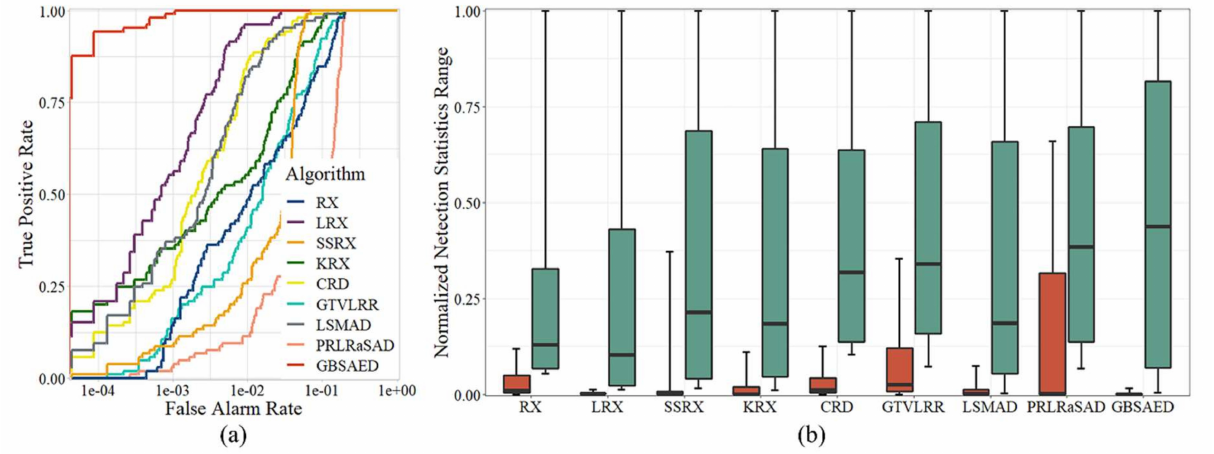
Figure 8. Quantitative analysis of the detection results of the various algorithms for the Belcher Bay Image: ( a ) ROC curves and ( b ) target-background separation map.